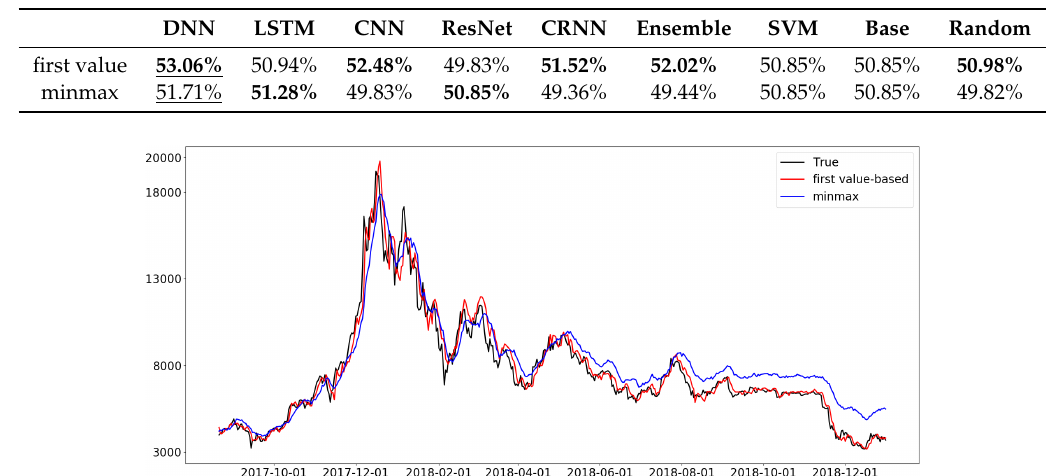
Table 12. Effect of normalization methods on classification (accuracy). The sequence size m = 20. The log values of the major features and the sequential partitioning were used.